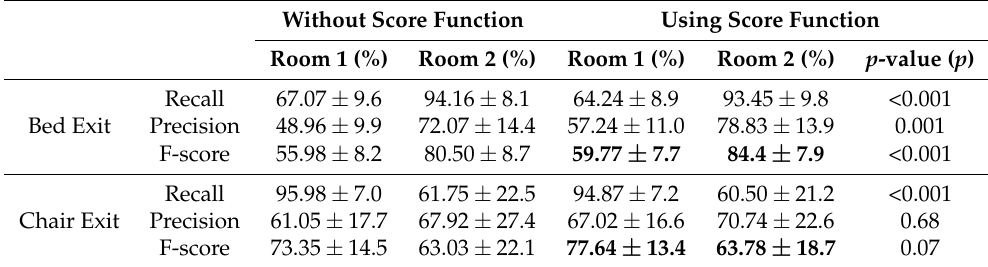
Table 1. Bed and chair exit recognition results for two room configurations. Comparison of recognition of bed and chair exits with and without the use of a score function. p -value corresponds to comparison between Room 1 and Room 2 using score function.